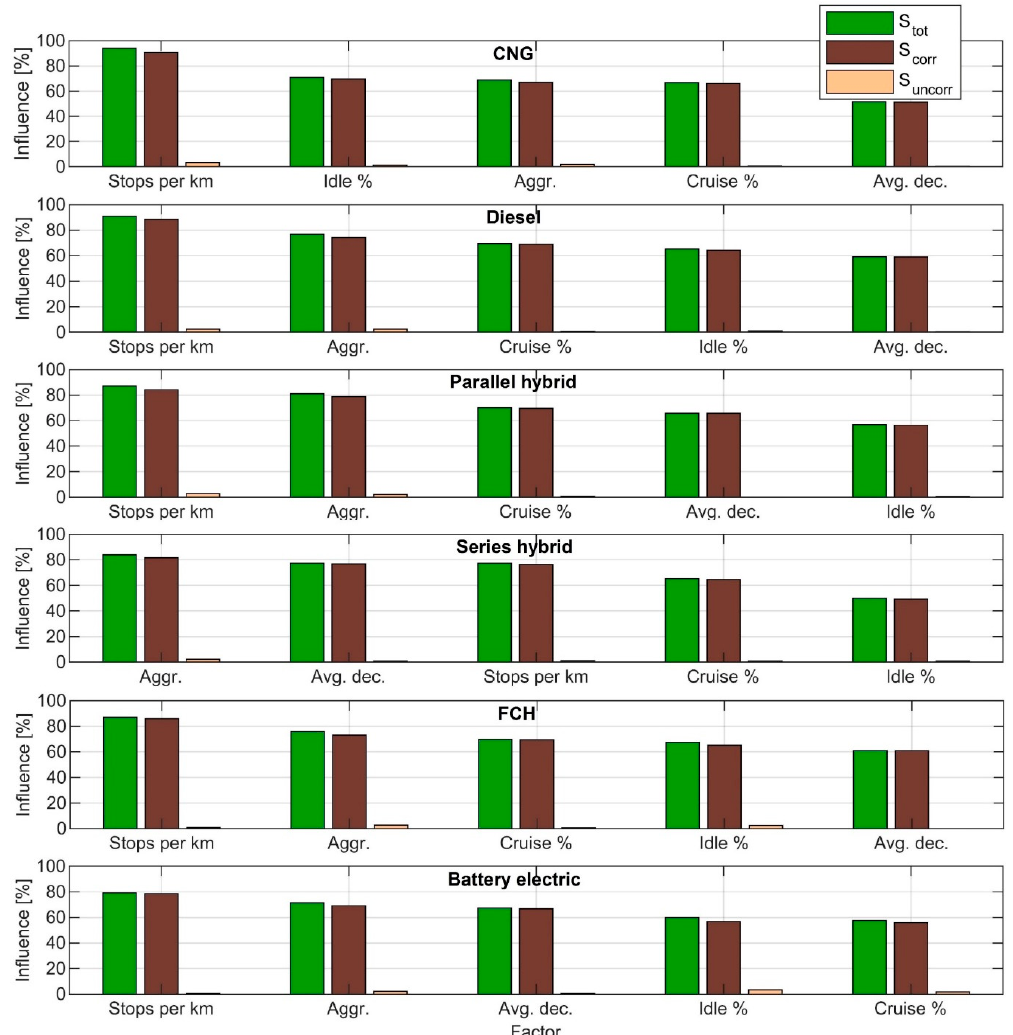
Figure 15. Variance decomposition analysis for the six buses on the 19 reference cycles. Table 13. Summary of pros and cons of the energy consumption characteristics of the different city bus powertrains.